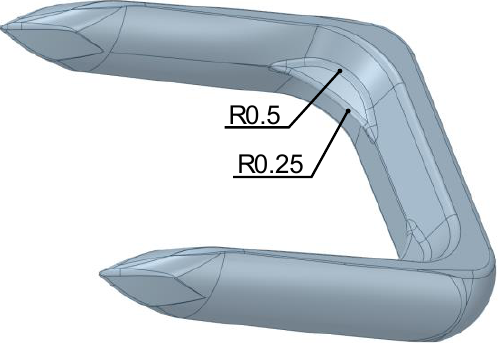
Figure 7. 3D CAD model of the staple with rounded sharp edges (mm).